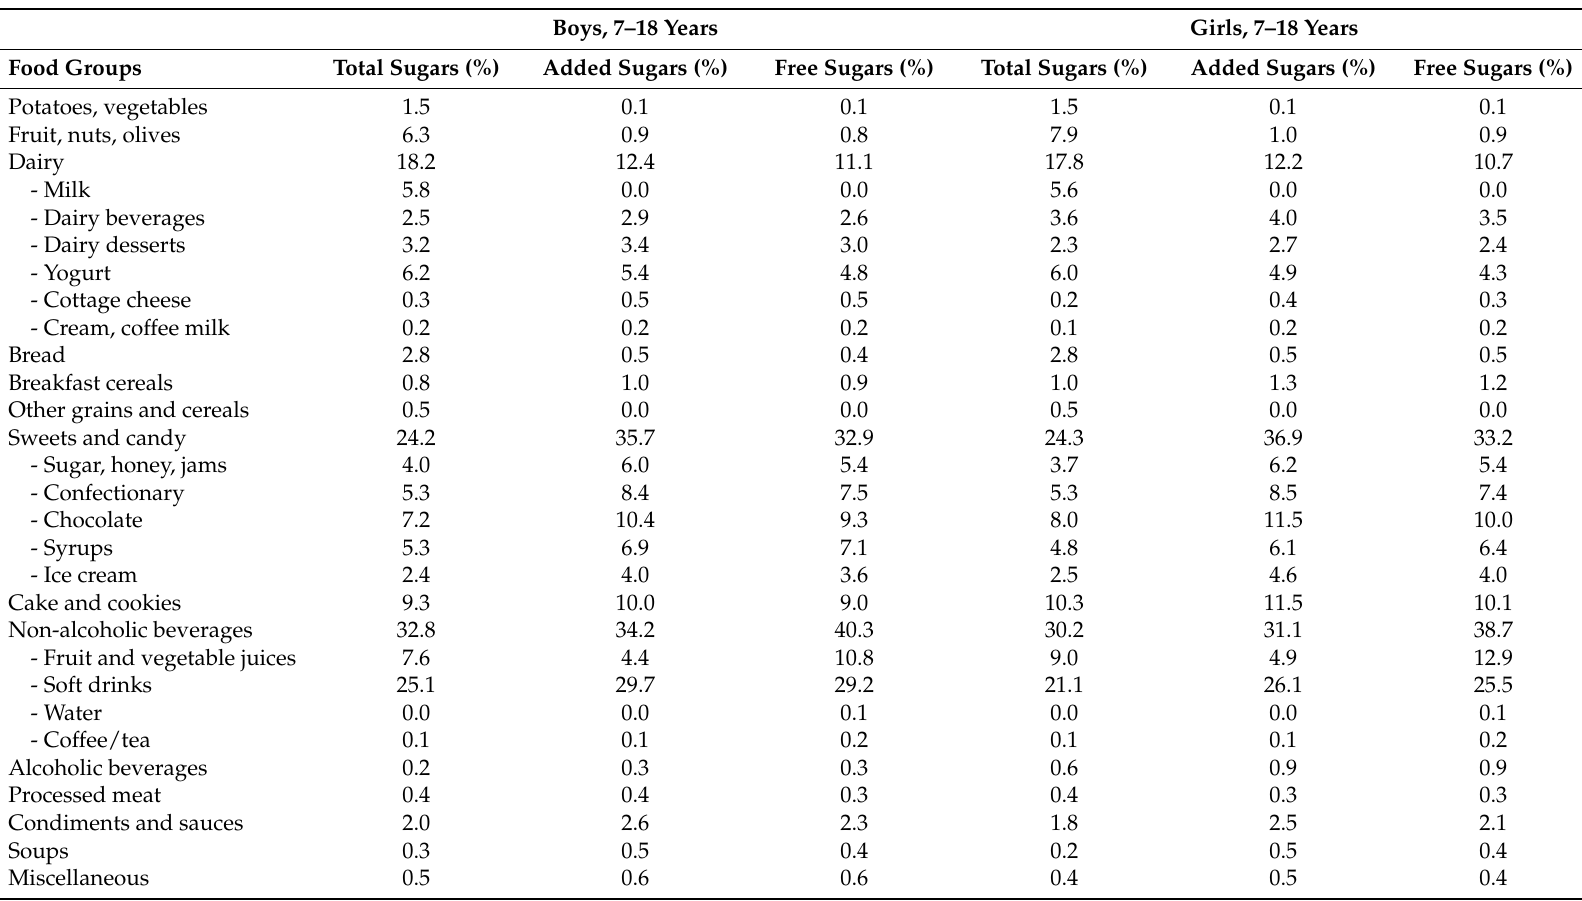
Table 2. Mean contribution (%) by food sources to intake of total sugars, added sugars, and free sugars in 3817 participants of the Dutch National Food Consumption Survey 2007–2010 according to age category and